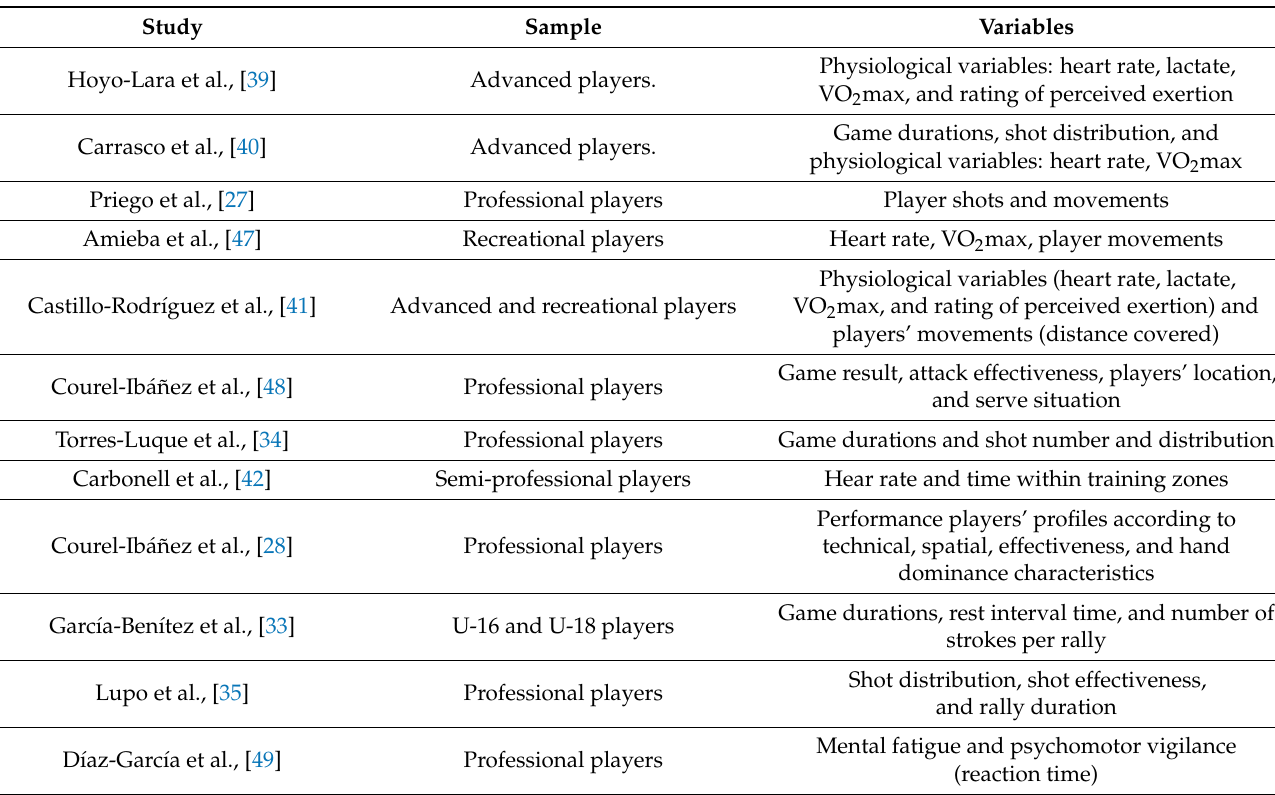
Table 1. Summary of studies exploring match-play demands in